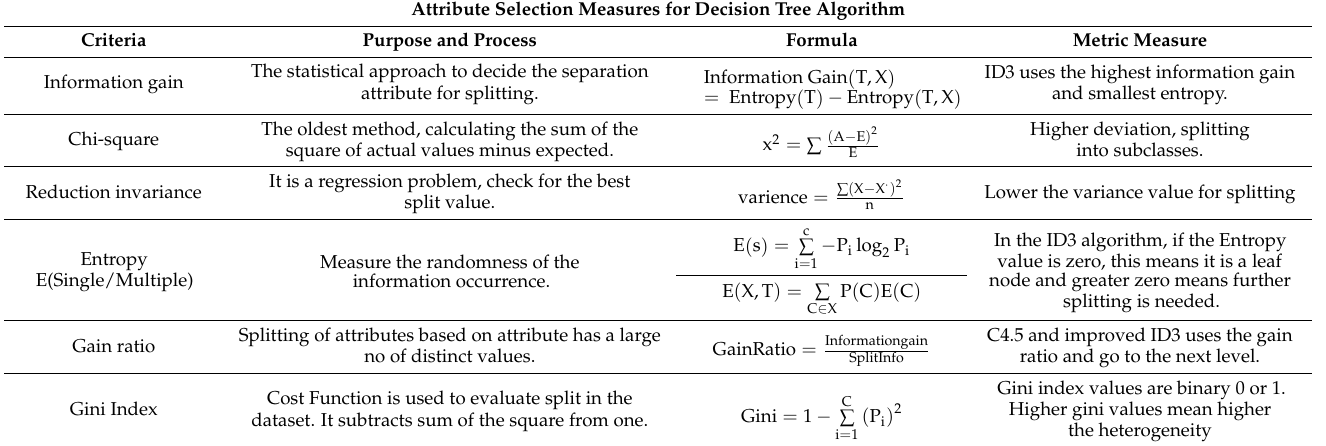
Table 3. Different attribute selection types for